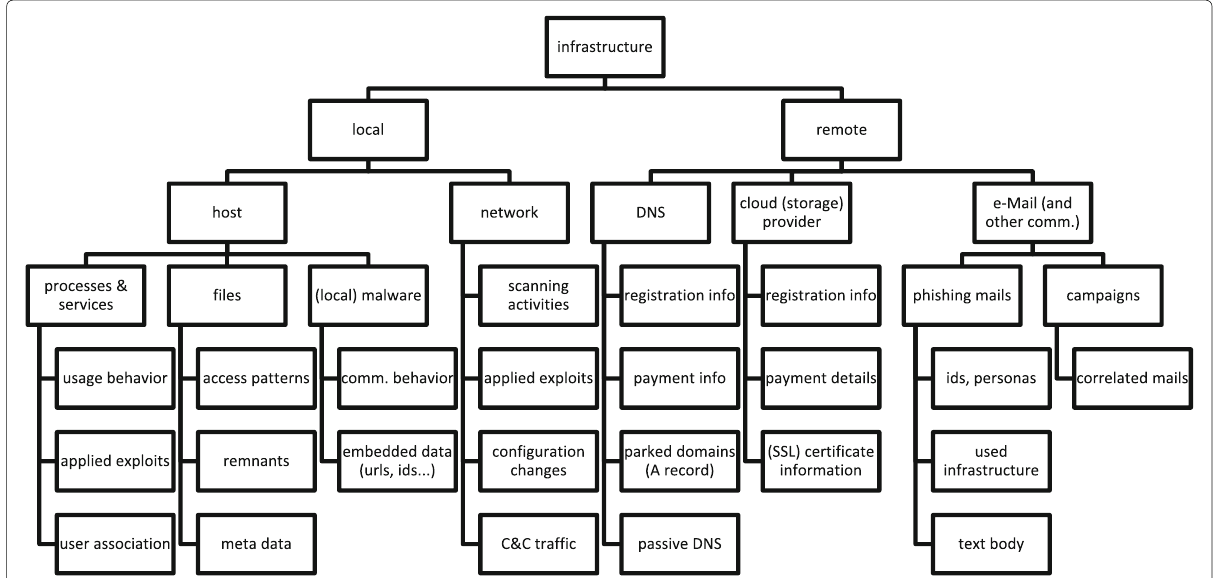
Fig. 4 Types of artifacts gathered from technical infrastructures that aid the attribution